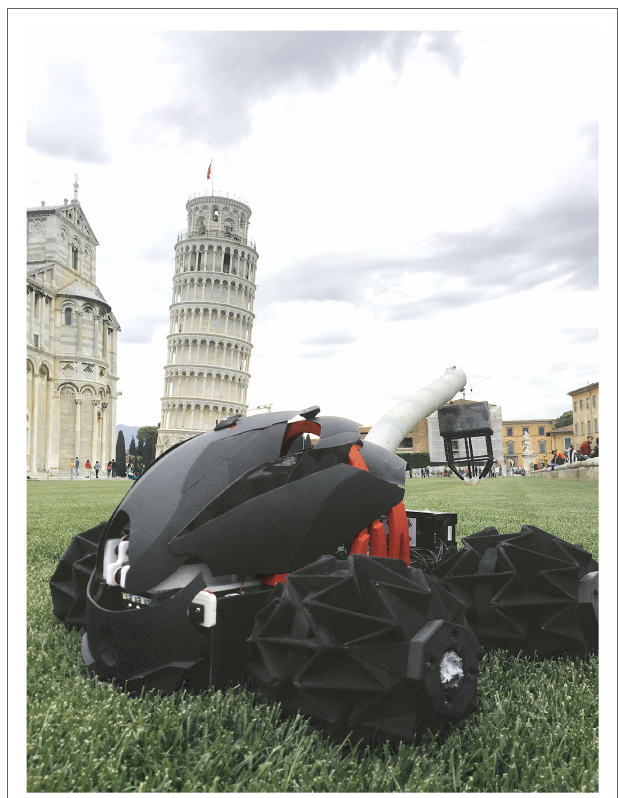
FigUre 1 | snUMaX completed all tasks of the robosoft grand challenge, thanks to its transformable origami wheels, polymer- based soft manipulator, and adaptive caging gripper